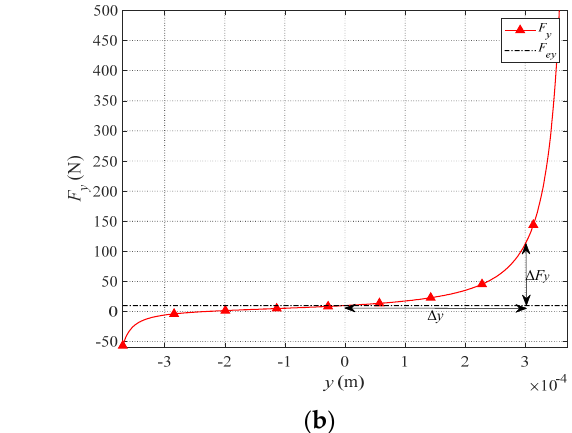
WI Figure 5. Improved current distribution control strategy proposed in this paper. 3.1. Improved EMF Model In Equations (11) and (12), M x and M y represent the characteristics of magnetic bear- ing with a redundant structure. They are mainly manifested in a magnetic field, reluc- tance, and other properties. Considering that the air gap between the magnetically-levi- tated rotor and the protective bearing is generally less than 0.3 mm, the displacement of the rotor center near the equilibrium position cannot be ignored. For the EMFs model in Equations (11) and (12), we can try to expand M x and M y using the Taylor series near the equilibrium position M (0, 0), as shown in Equations (21) and (22).